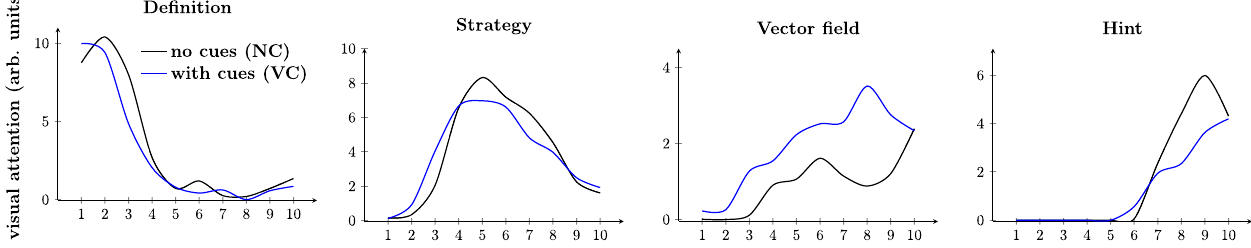
FIG. 5. Students ’ attention allocation on the instruction page across 10 equal time intervals, separated by